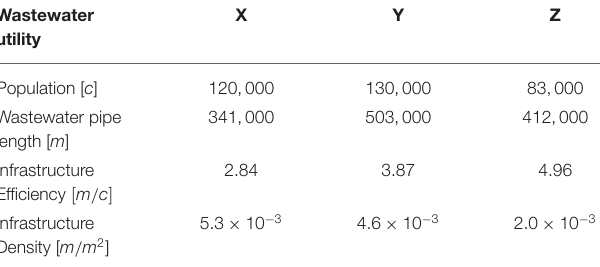
TABLE 4 | Demographic information of wastewater